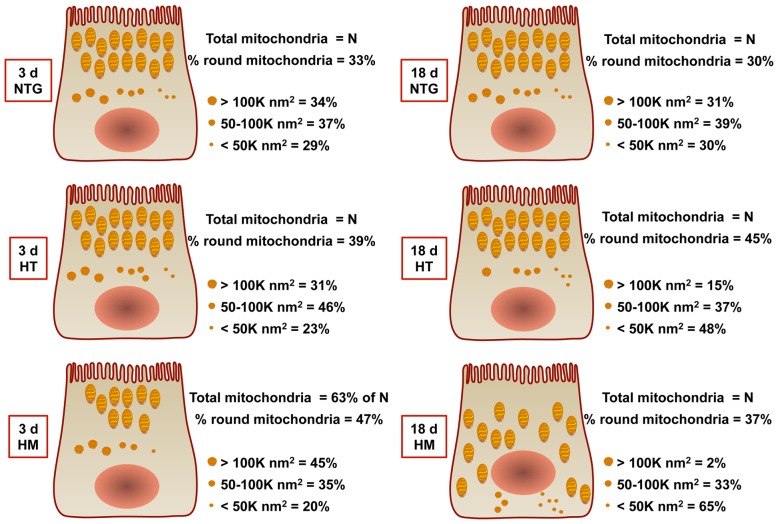
Over-expression of myrAKT was associated with changes suggestive of stalled mitochondrial fission.No differences were observed for percentages of round midgut mitochondria among NTG, HT, or HM myrAkt transgenic An. stephensi at 3 d and 18 d post-emergence (ANOVA following arcsin transformation; alpha = 0.05). In all groups except for 18 d HM, midgut mitochondria were associated with the brush border. In 18 d HM, midgut mitochondria were distributed throughout the cell. Further, size distributions of round mitochondria in NTGs were significantly different from those in HT and HM midguts at 3 d (NTG vs HT: χ2 = 20.5, df = 2, P<0.0001; NTG vs HM: χ2 = 19.6, df = 2, P<0.0001) and at 18 d (NTG vs HT: χ2 = 54.8, df = 2, P<0.0001; NTG vs HM: χ2 = 244, df = 2, P<0.0001). In addition, within each TG genotype (HT and HM), there were significant differences in size distributions of round mitochondria between samples analyzed from 3 d and 18 d An. stephensi (3 d HT vs 18 d HT: χ2 = 182, df = 2, P<0.0001; 3 d HM vs 18 d HM: χ2 = 457, df = 2, P<0.0001).